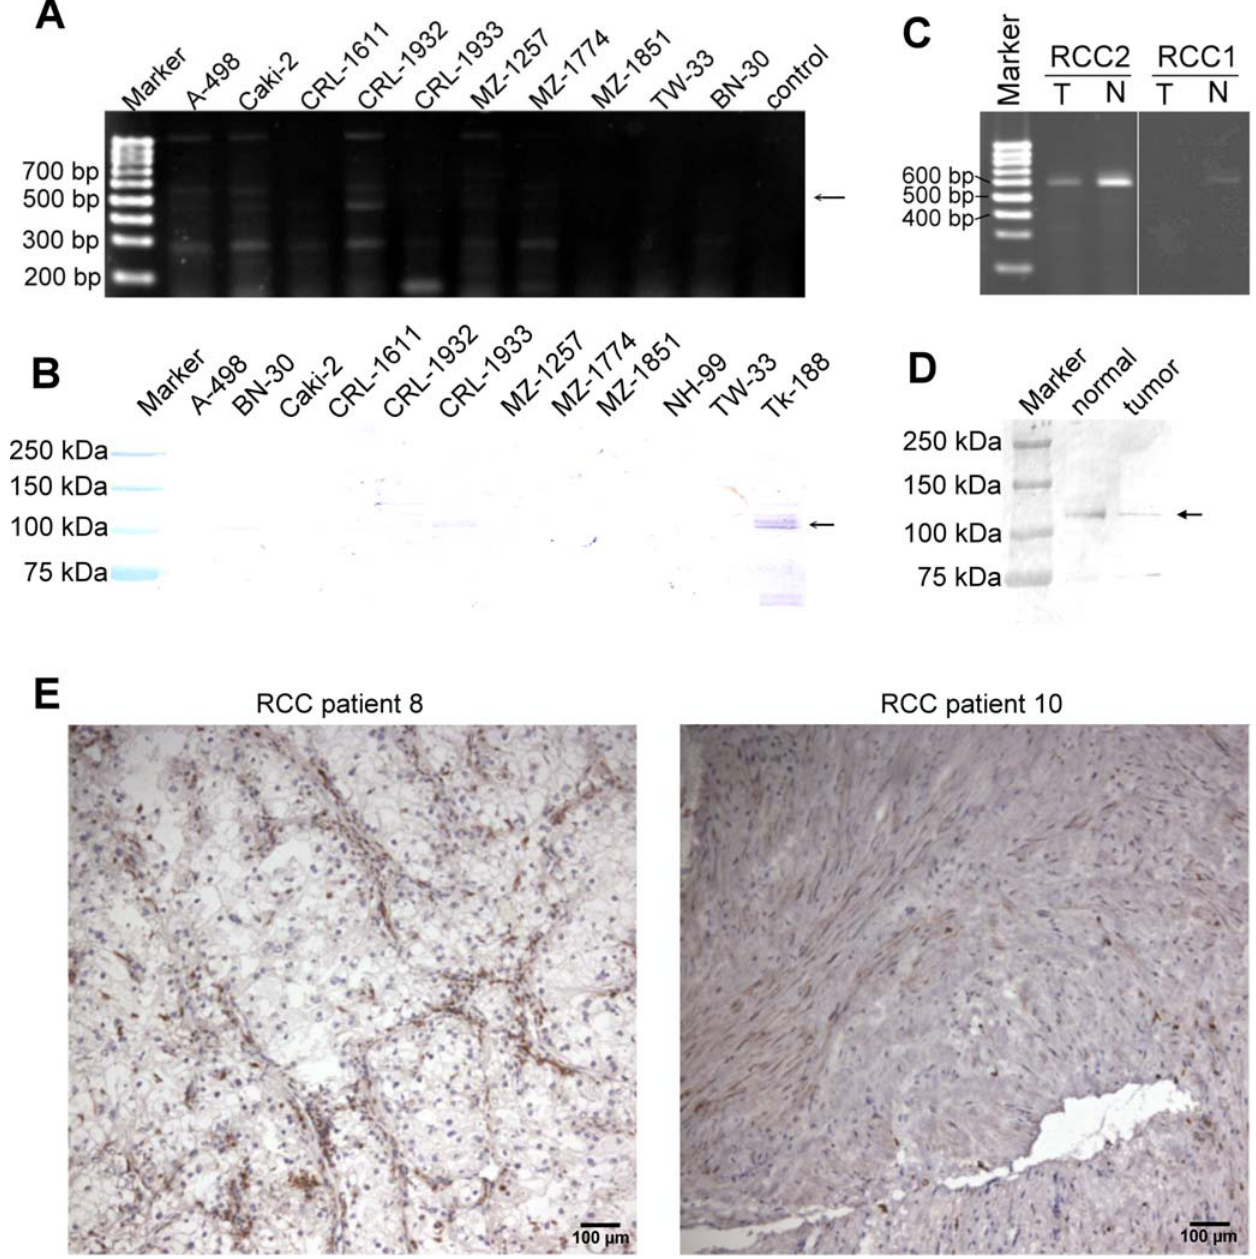
Figure 6. In renal cell carcinoma, cadherin-9 is exclusively expressed by the tumour stroma. (A, B) RT-PCR and Western blot analyses of ten or eleven RCC cell lines, respectively, revealed that cadherin-9 was not expressed in any of the cell lines tested. In the Western blot analysis, the signal detected in the TK 188 cell lysate served as a positive control. (C, D) The signals for cadherin-9 expression detected by RT-PCR or Western blot analyses in renal tumor tissue were constantly much weaker compared to the normal kidney tissue adjacent to the tumor which appeared normal in histology. (E) The immunohistochemical staining of RCC sections showed that cadherin-9 marked exclusively the tumor stroma. Bars, 100 m m. Pictures of the immunoblots (B,D) were